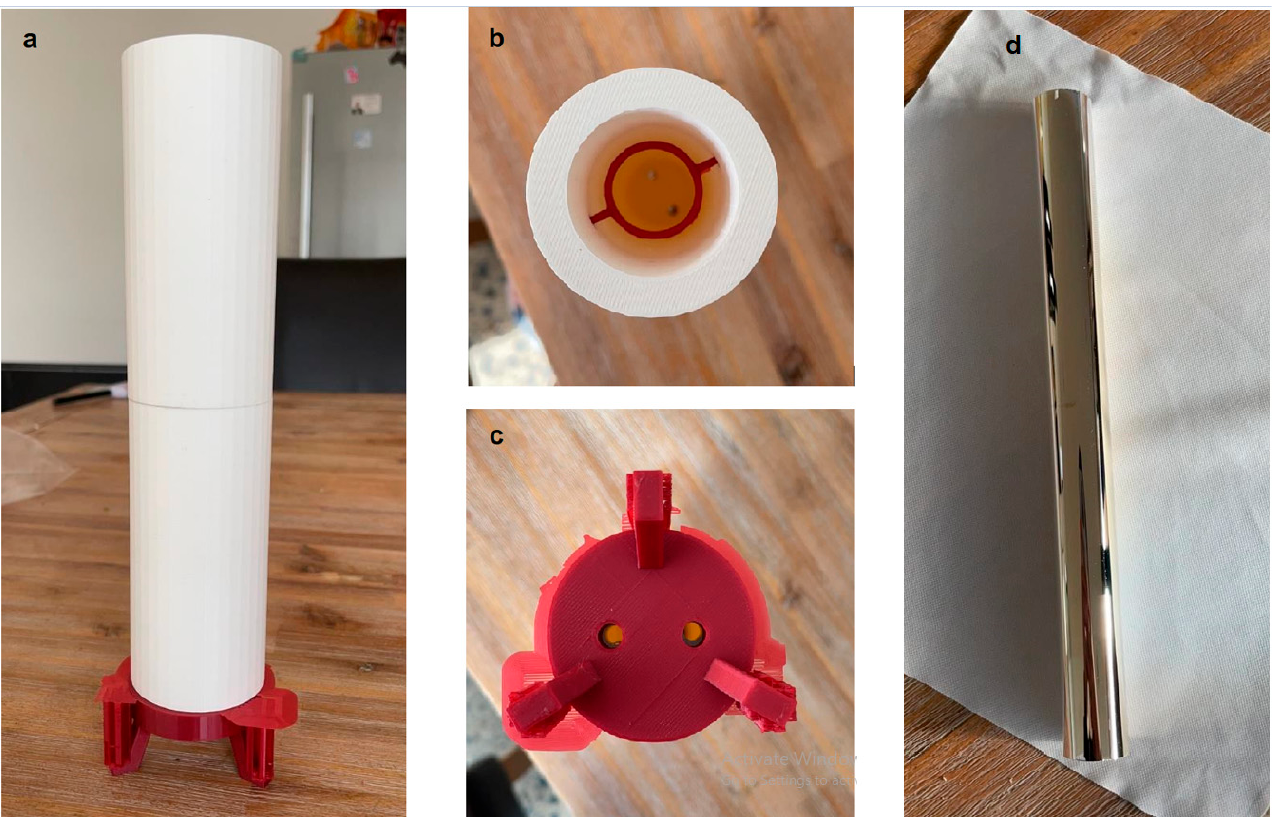
Figure 6. 3D-printed container ( a ), top view ( b ), bottom view ( c ), the coated container after fabrica- tion ( d ).